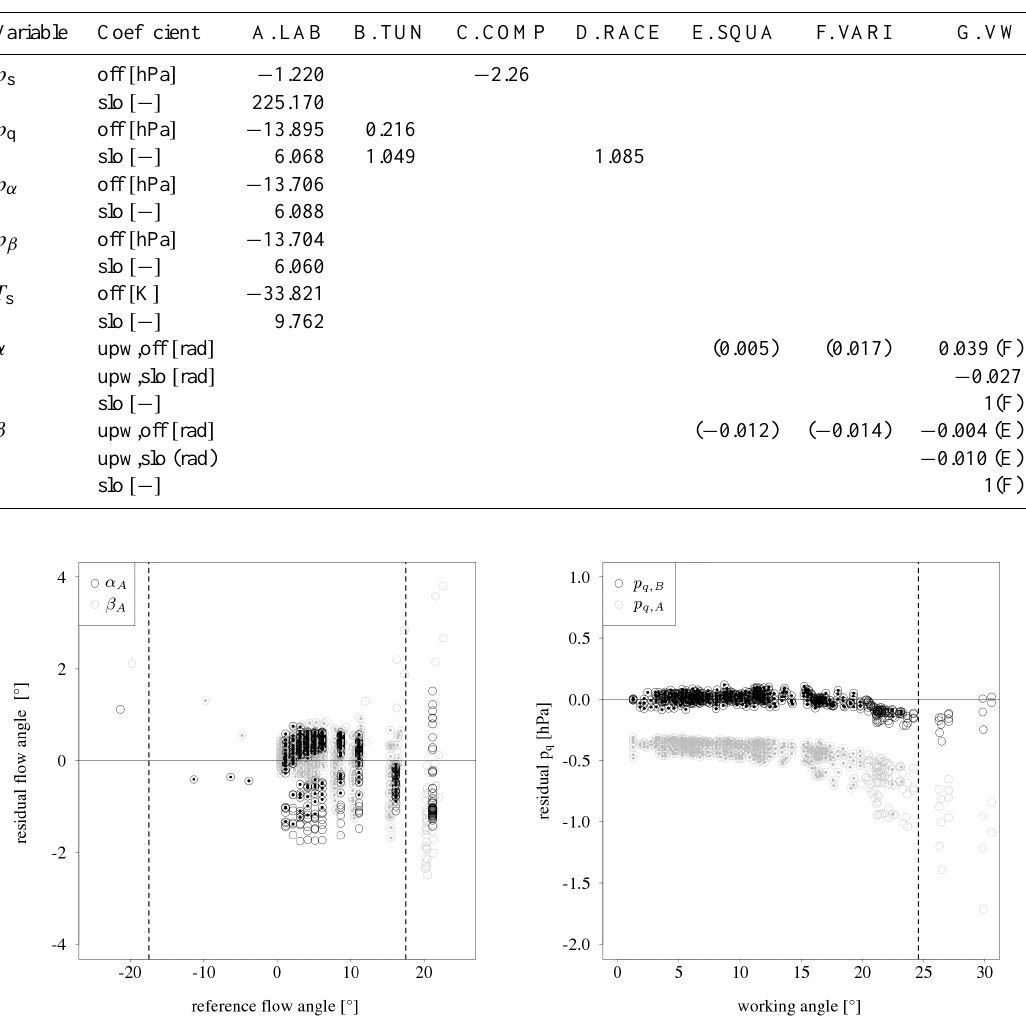
Table 6. Coefficients for static pressure ( p s ), dynamic pressure ( p q ), differential pressures ( p α , p β ), static temperature ( T s ), and flow angle measurements ( α , β ) during calibration Steps A–G. Respective environments are laboratory (LAB), wind tunnel (TUN), comparison to ground based measurements (COMP), racetrack (RACE), wind square (SQUA), variance optimization (VARI) and vertical wind (VW) specific flight patterns. Coefficients are distinguished in offset (off) and slopes (slo), where applicable with lift coefficient in the upwash corrections (upw). Cross-calibration is referred to with the calibration steps in parentheses. Coefficients in parentheses were only used for intermediate calculations.